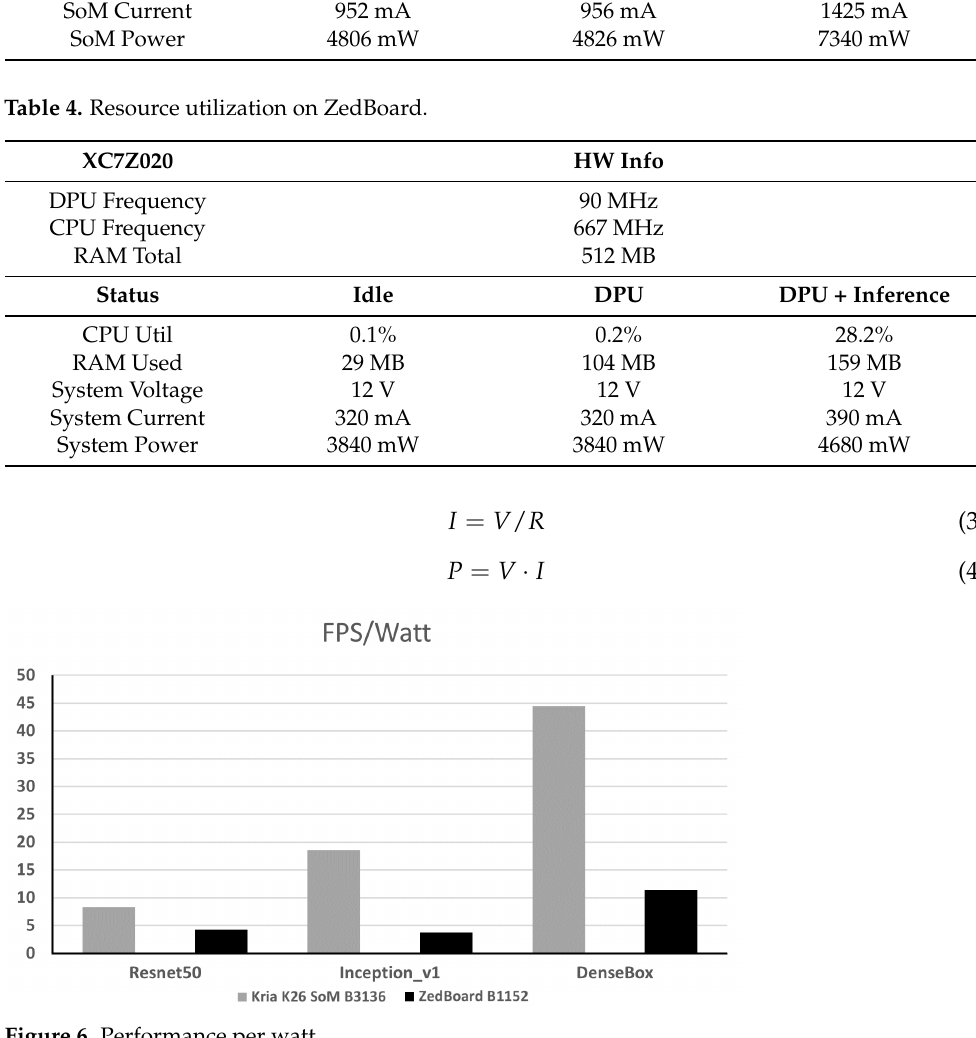
Figure 6. Performance per